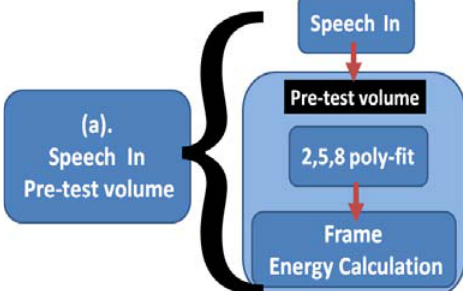
Figure 9. Speech In pre-test